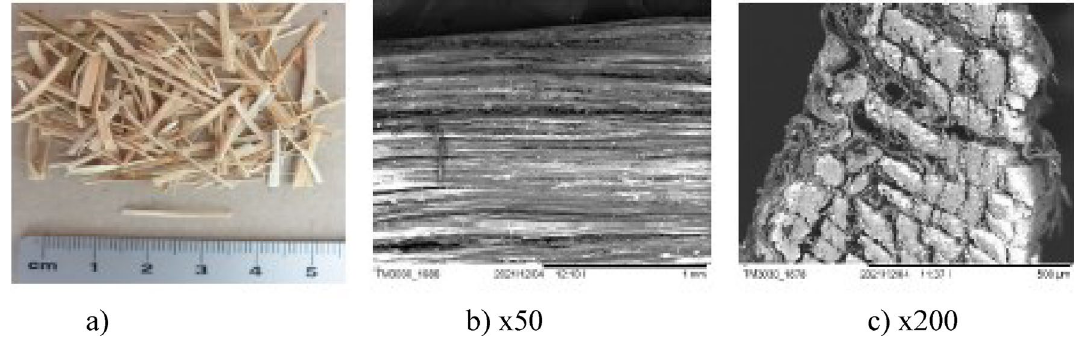
Figure 6. SEM of jute fibre